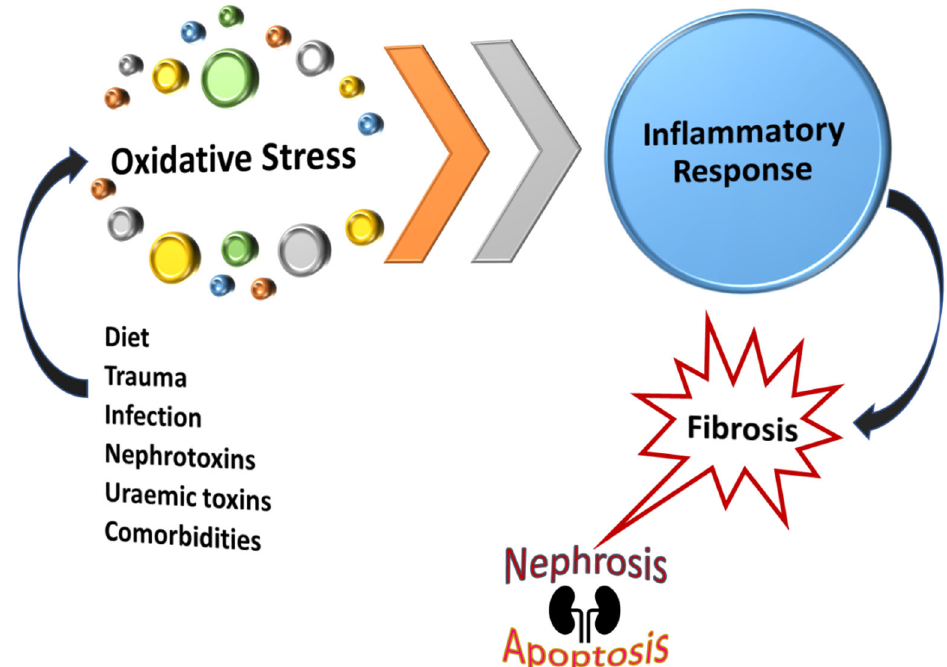
Figure 7. Oxidative stress in acute and chronic kidney disorders is associated with the development of RPN and fibrosis. A high concentration of oxidative stress products is associated with several toxic factors, subsequently triggering an inflammatory response, and leading to kidney damage.